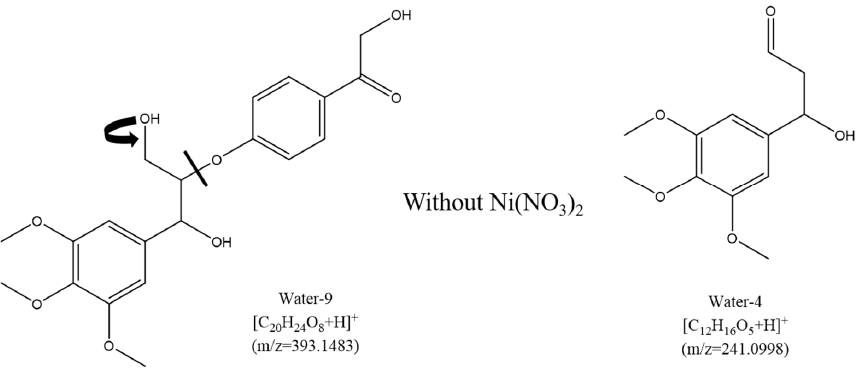
Figure 7. Proposed pathway for the formation of species of m / z = 241 in “Water”. Characteristics of C-H bond of compounds in bio-oil were analyzed and shown in Figure 8. The 2D HSQC NMR spectra were divided into two regions, aromatic ( δ C/ δ H = 95 − 120/5.5 − 8.0 ppm) and aliphatic side-chain ( δ C/ δ H = 50 − 95/3.0 − 5.5 ppm). According to literature [29,41,42], the species of primary units were all found in the three groups, which were C − H in methoxy at δ C/ δ H = 56.4/3.71 ppm, C γ − H γ in β -O-4 substructures at δ C/ δ H = 61.0/3.40 ppm, various C γ − H γ in side chain at δ C/ δ H = 63.4/3.45 ppm, C and C 5 − H 5 in guaiacyl units at δ C/ δ H = 110.9/6.96 and 115.5/6.78 ppm, C 2,6 − H 2,6 in syringyl units and p-hydroxyphenyl units at δ C/ δ H = 104.6/6.79 and 127.6/7.16 ppm. The signals of C-H bond of compounds in bio-oil obtained from 2D HSQC NMR were consistent with the structures in Figure 6 derived from the results of ESI-MS and GPC.